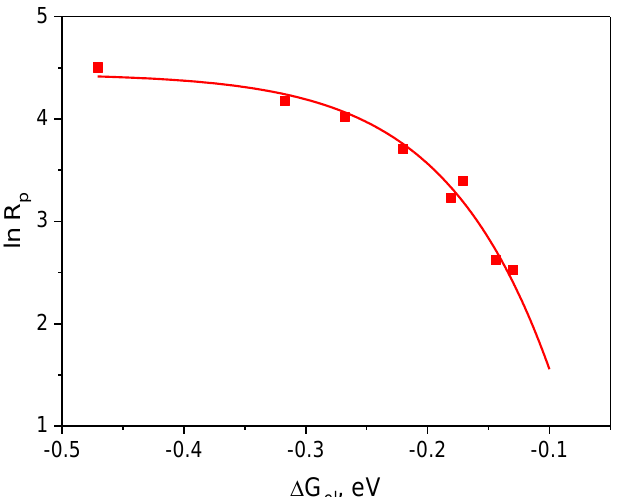
Figure 7. The dependence of the initial polymerization rate on the thermodynamic potential of an activation of the electron transfer process from the electron donor to the excited triplet state of acenaphthoquinoxaline dyes.